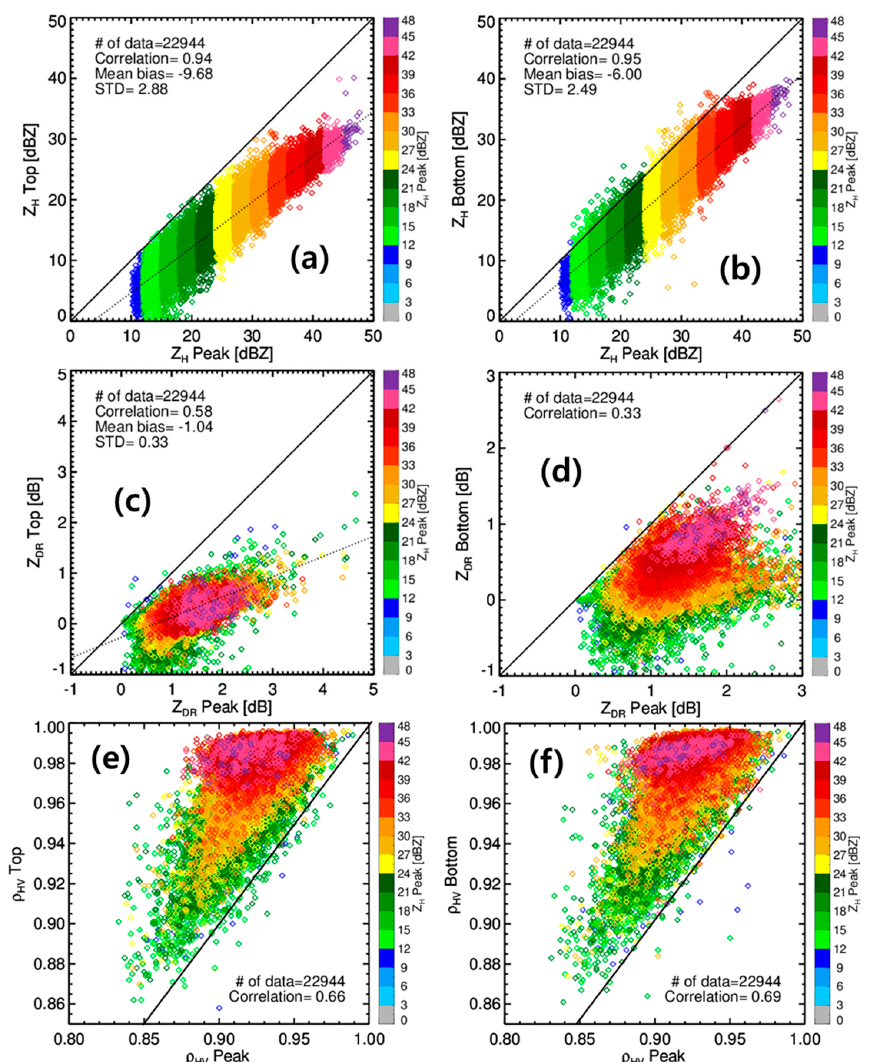
Figure 13. Scatter plots of ( a ) Z H Top and Z H Peak, ( b ) Z DR Top and Z DR Peak, ( c ) ρ HV Top and ρ HV Peak, ( d ) Z H Bottom and Z H Peak, ( e ) Z DR Bottom and Z DR Peak, and ( f ) ρ HV Bottom and ρ HV Peak. Colors indicate the Z H Peak with 3 dBZ intervals. Remote Sens. 2020 , 12 , x 17 of 20